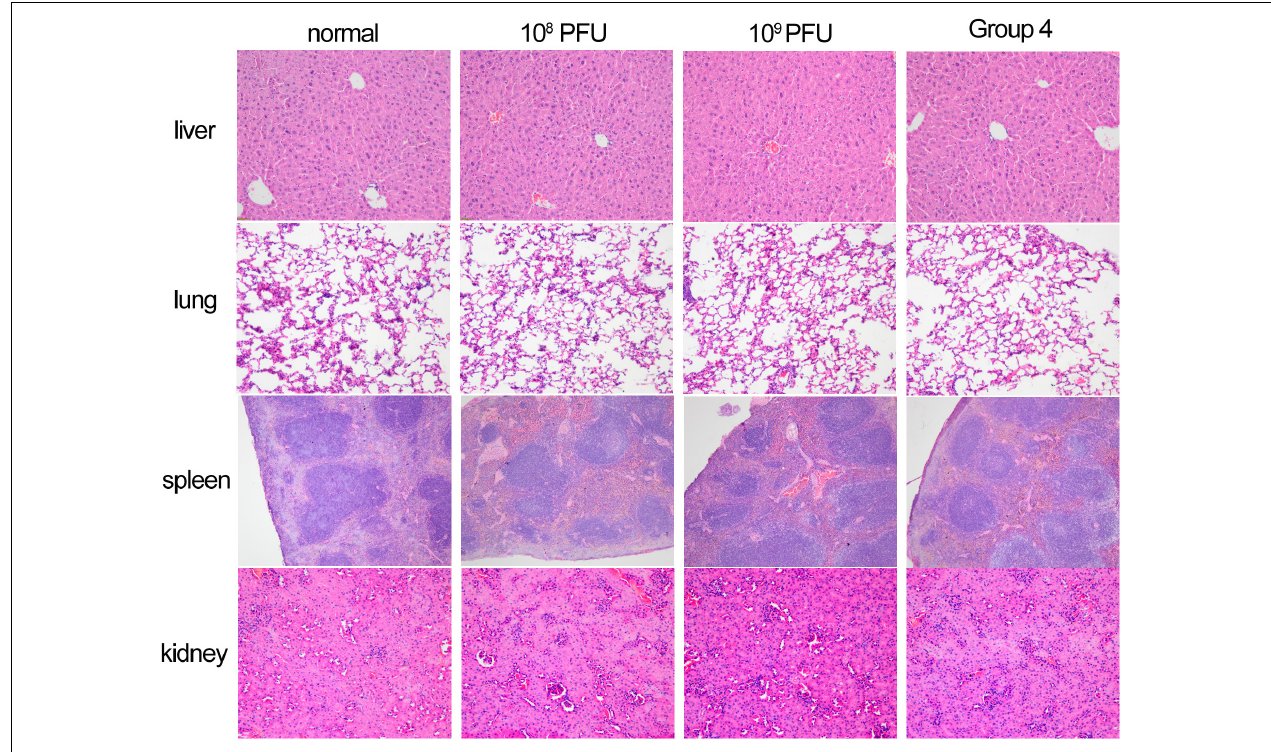
FIGURE 4 | Histopathology of spleen, lung, kidney and liver tissues from normal mouse, mice used to detect the toxicity of different doses of kpssk3 (10 8 PFU/mouse and 10 9 PFU/mouse), and phage-rescued mouse.